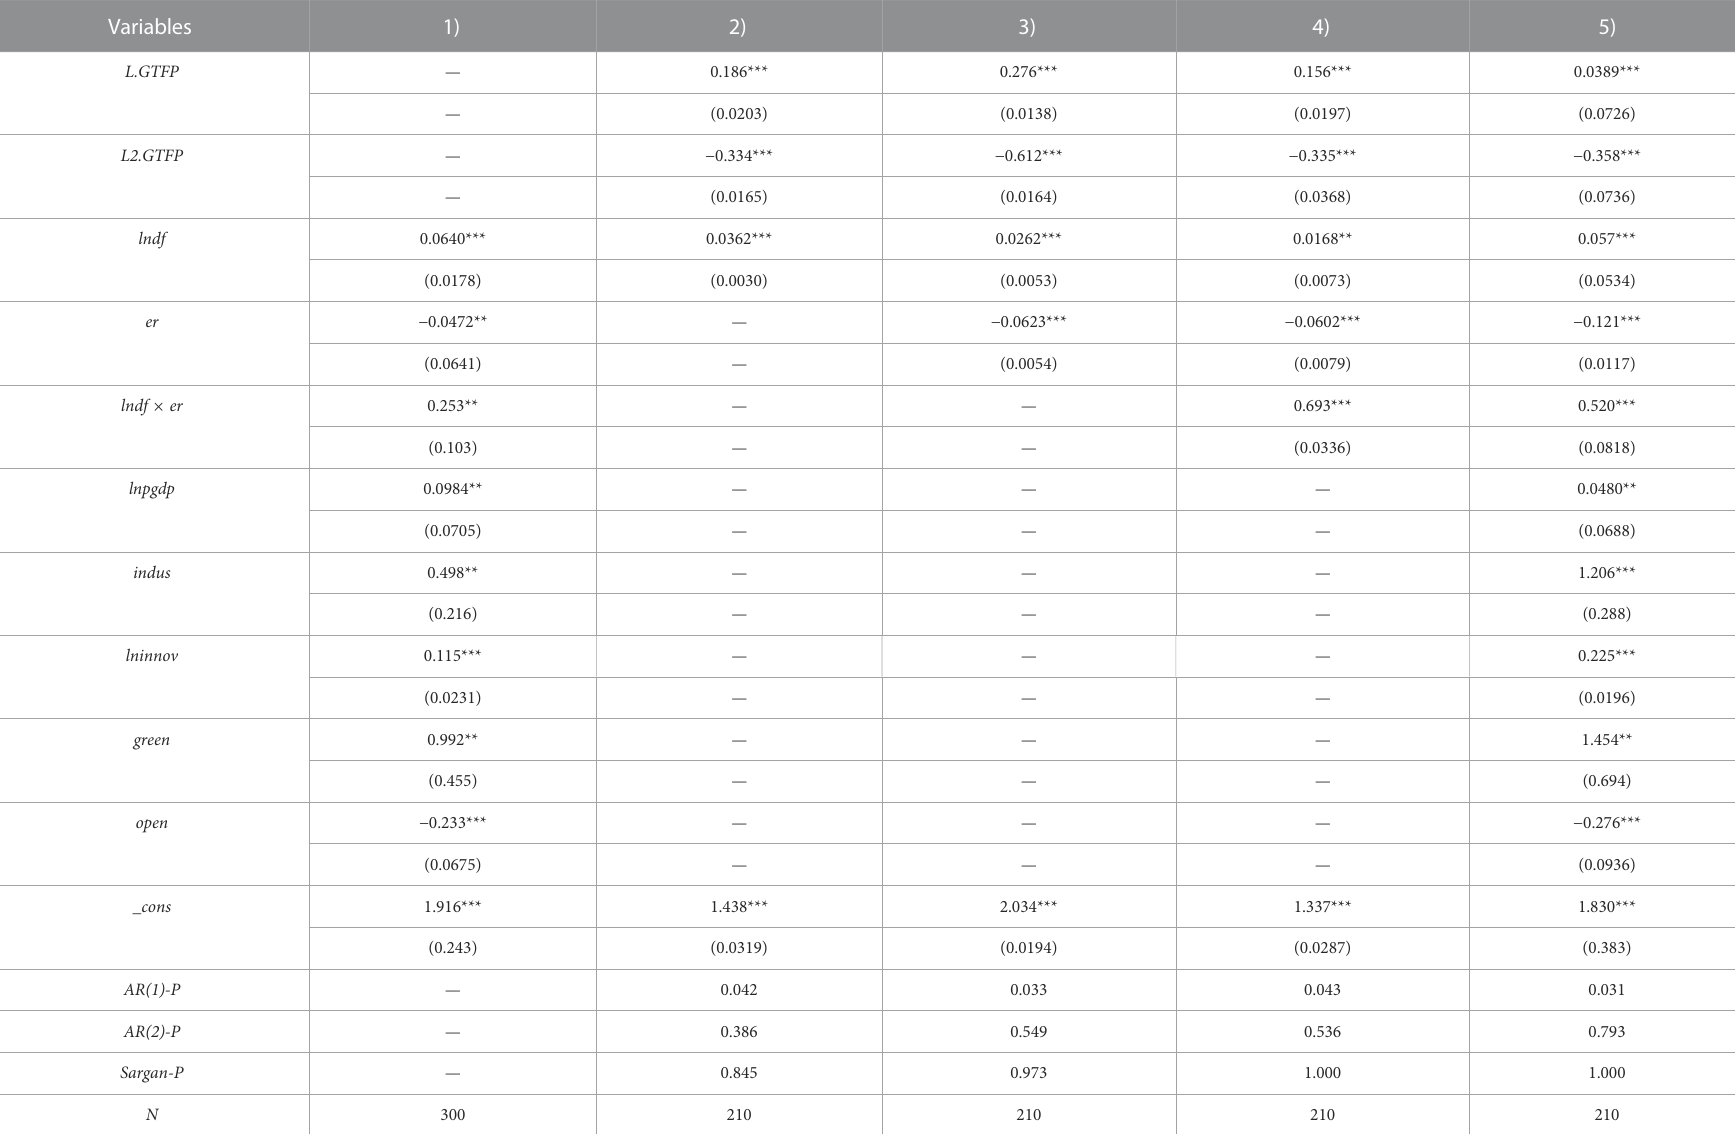
TABLE 2 Regression results of the dynamic panel GMM